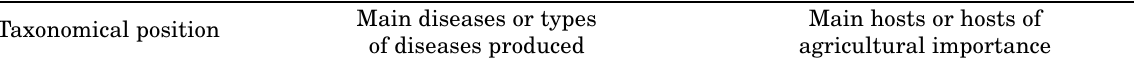
Table 1. Classification of phytopathogenic bacteria and the diseases they produce a